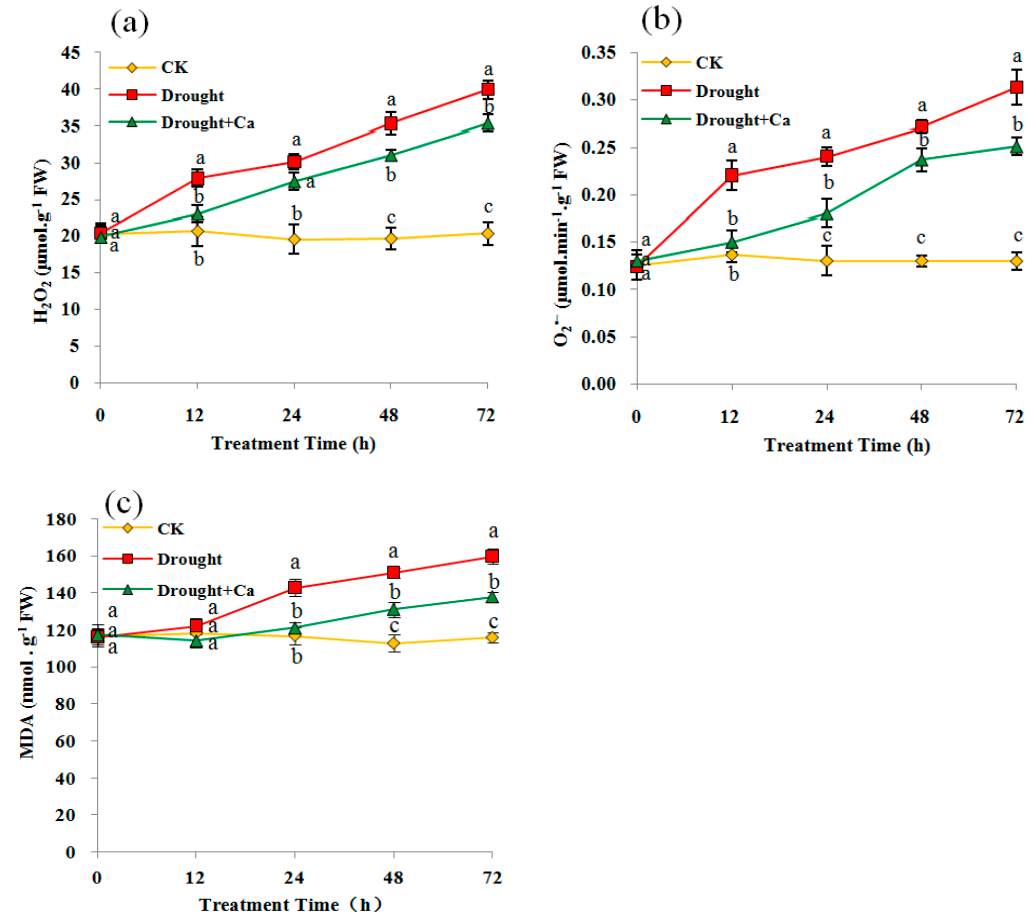
Figure 3. ( a ) H 2 O 2 content, ( b ) O 2 •− content, ( c ) Lipid Peroxidation (MDA content) in C. glauca leaves under drought stress and amended with Ca 2+ . The details of the treatments are given in the legend of Figure 2.